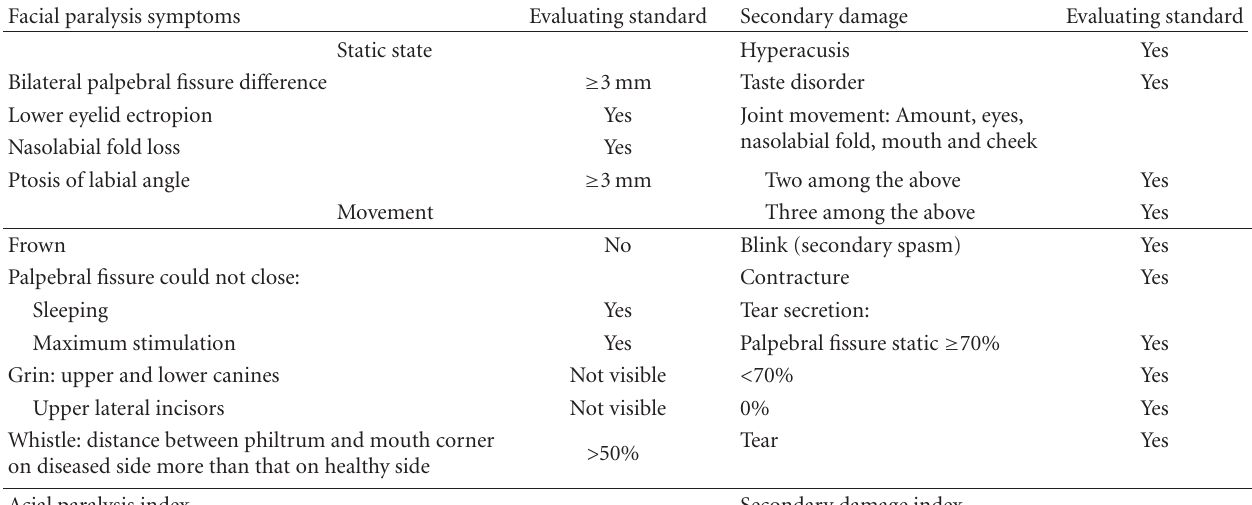
Table 1: Stennert